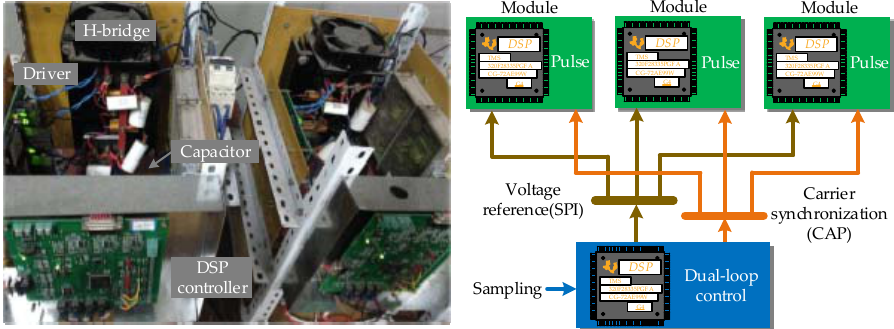
Figure 14. Module picture of CHB ‐ STATCOM prototype and hierarchical control structure.